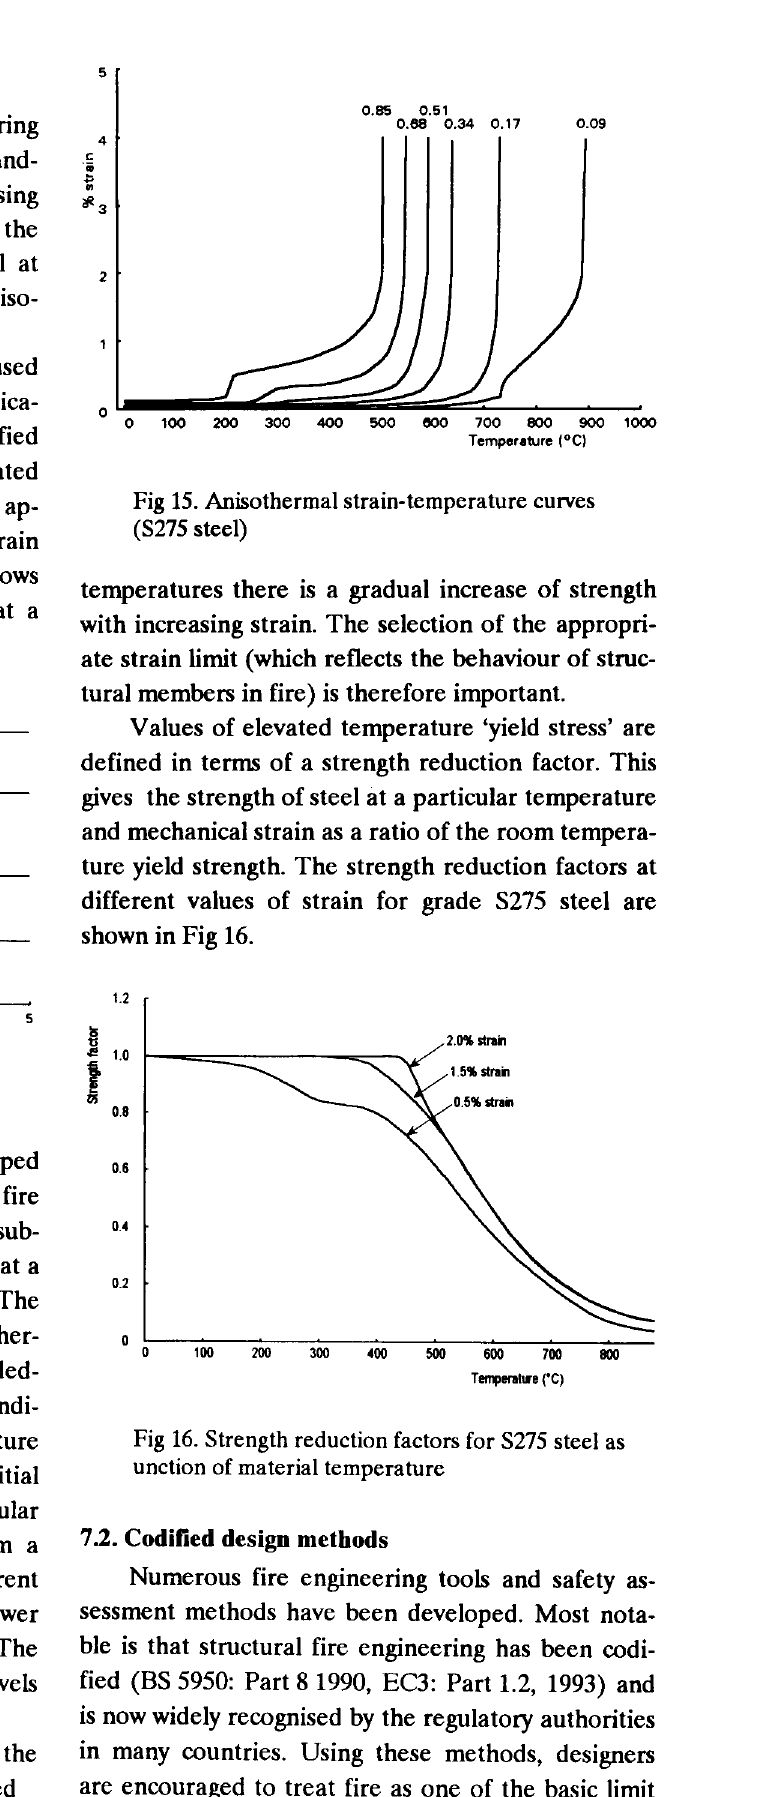
Fig 16. Strength reduction factors for S275 steel as unction of material